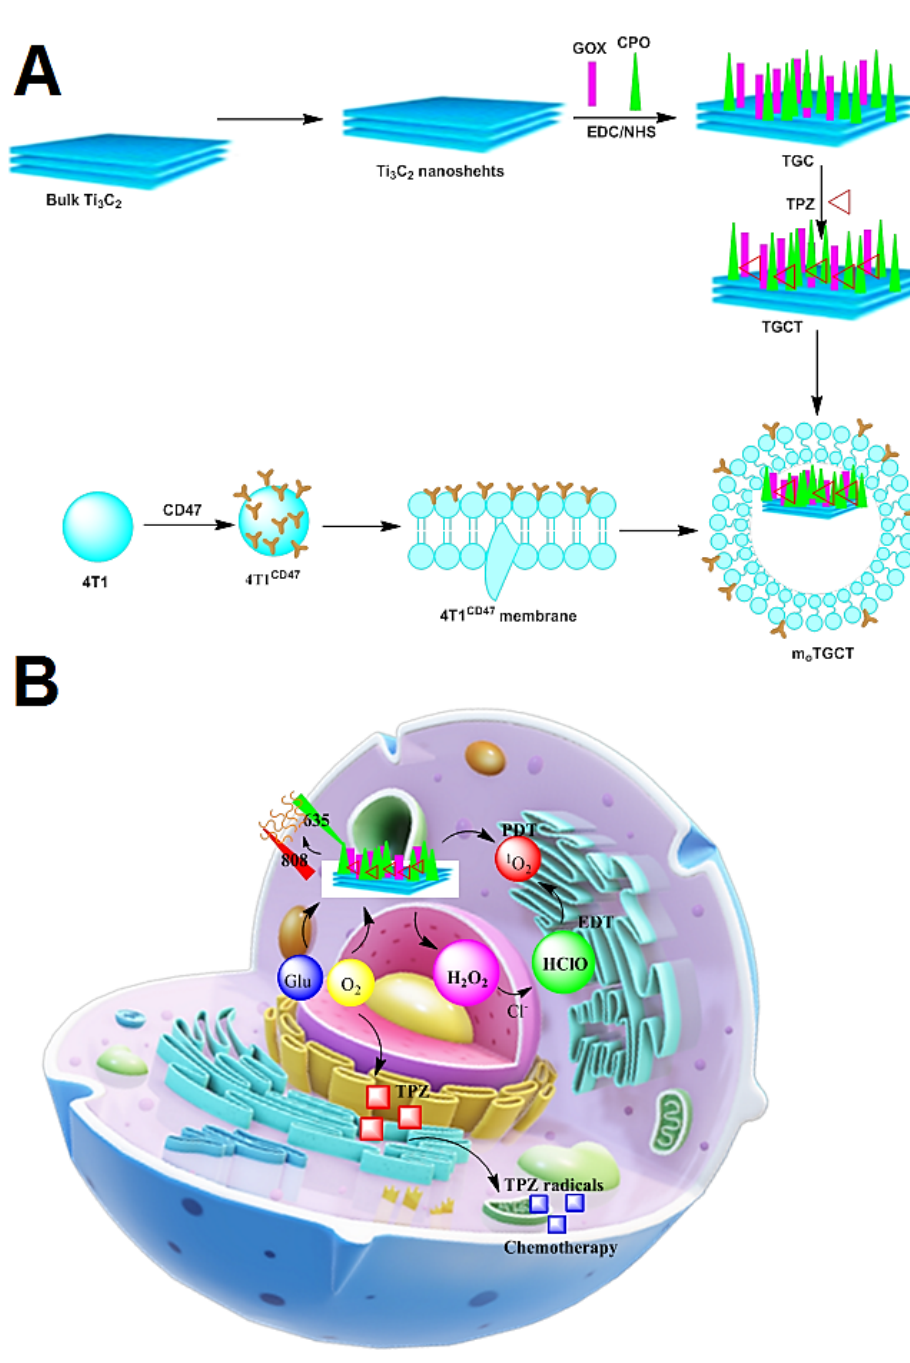
Figure 5. ( A ) Schematic diagram of Ti 3 C 2 nanosheet-based camouflaged bionic cascaded-enzyme nanoreactor. ( B ) The possible mechanism of action for the designed MXene-based camouflaged bionic cascaded-enzyme nanoreactor (in vivo) [100].